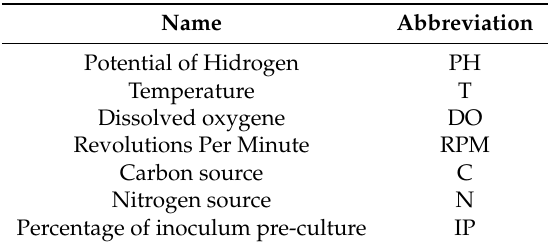
Table 1. Biological